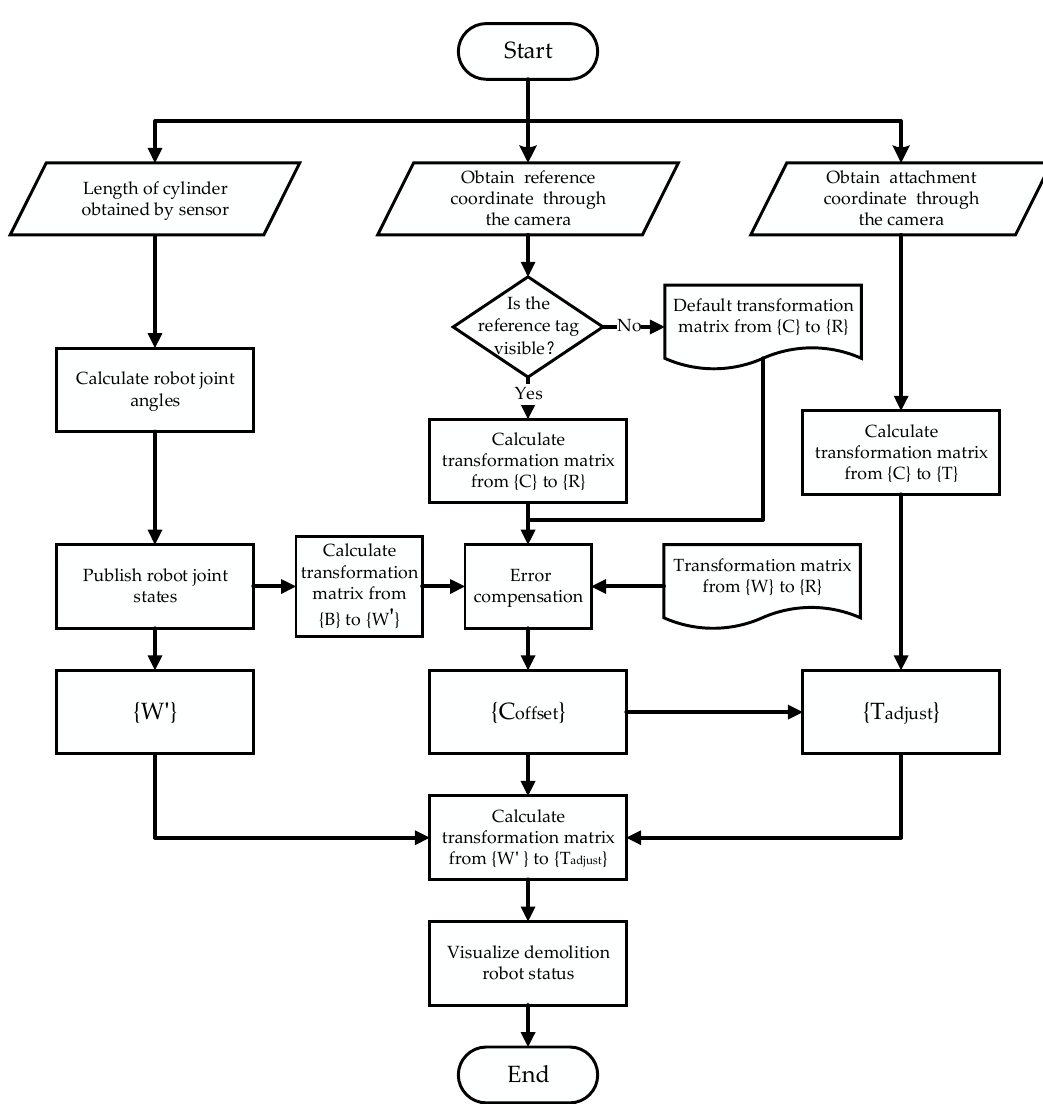
Figure 8. Block diagram of the error compensation algorithm.